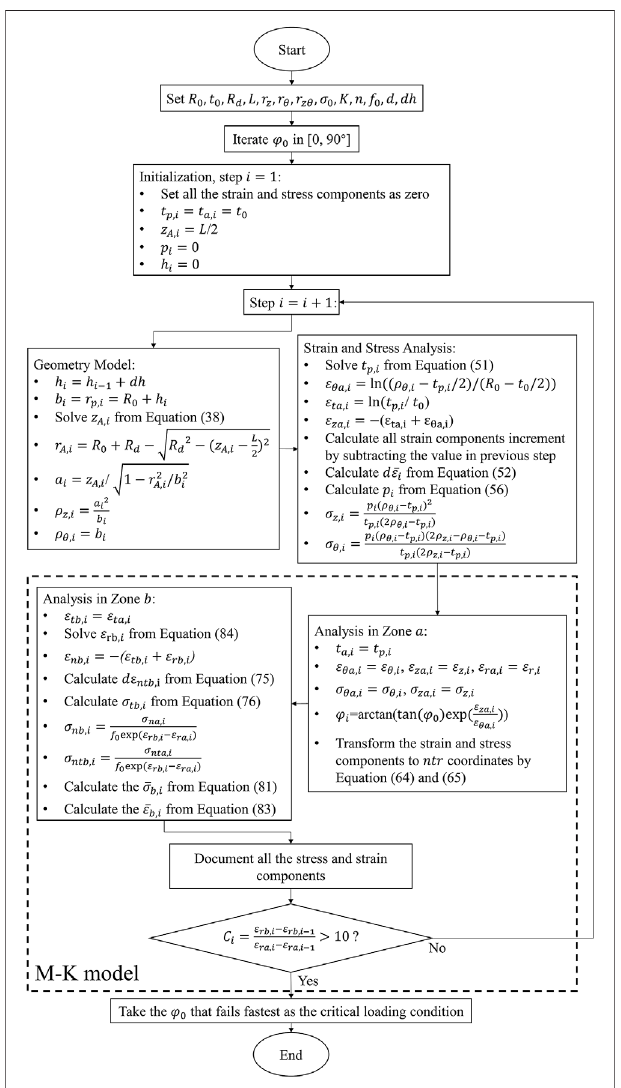
FIGURE 6 | Flow chart of the failure prediction model.